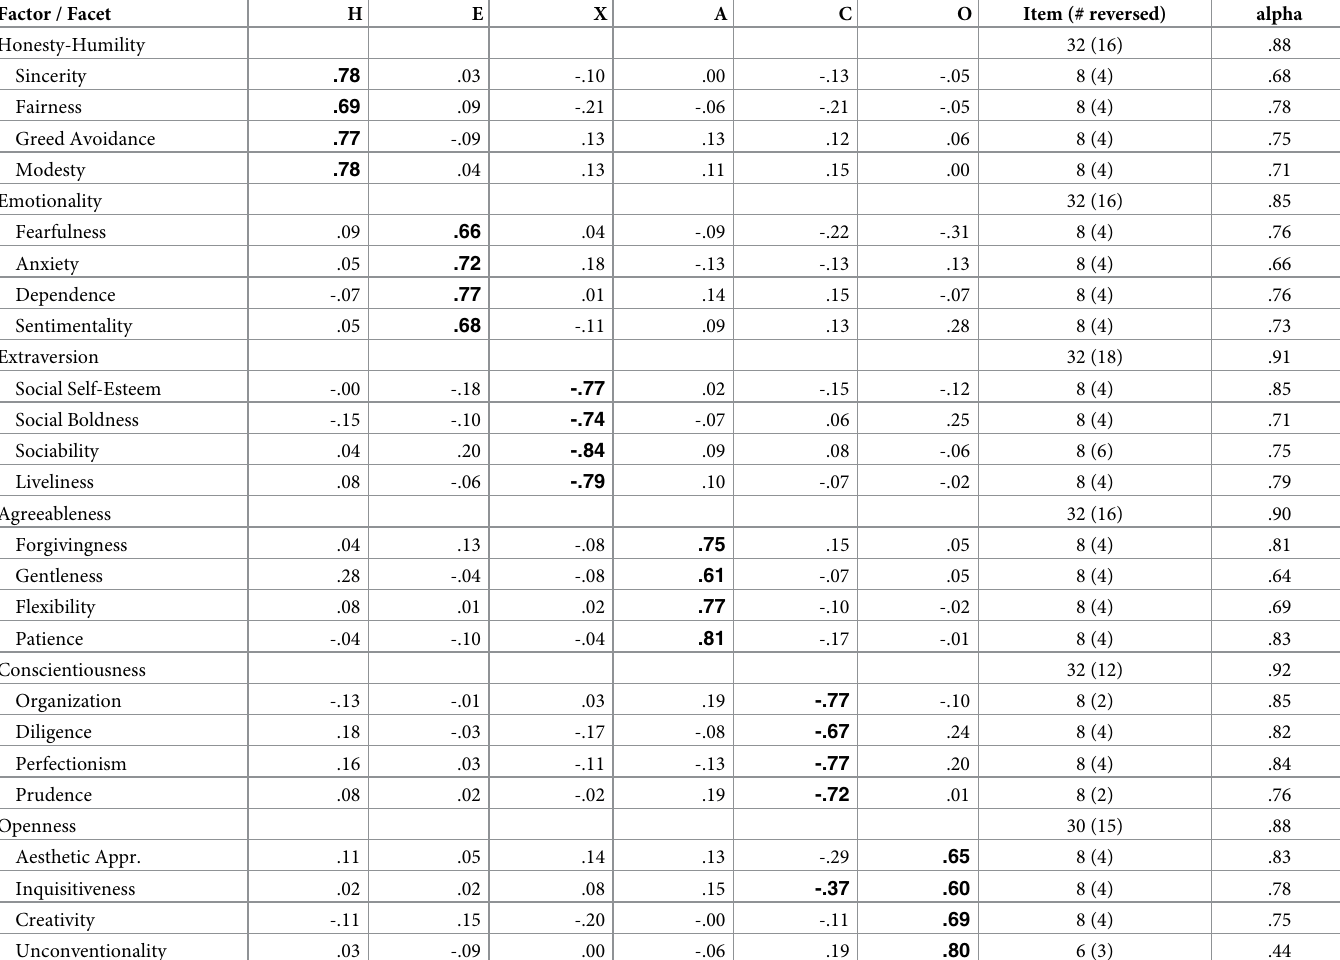
Table 2. Factor loadings (oblimin rotation) of the PCA on the facets of the 190-item HEXACO-MSI, normal and reversed items, and alpha coefficients for factors and facets based on items (Study